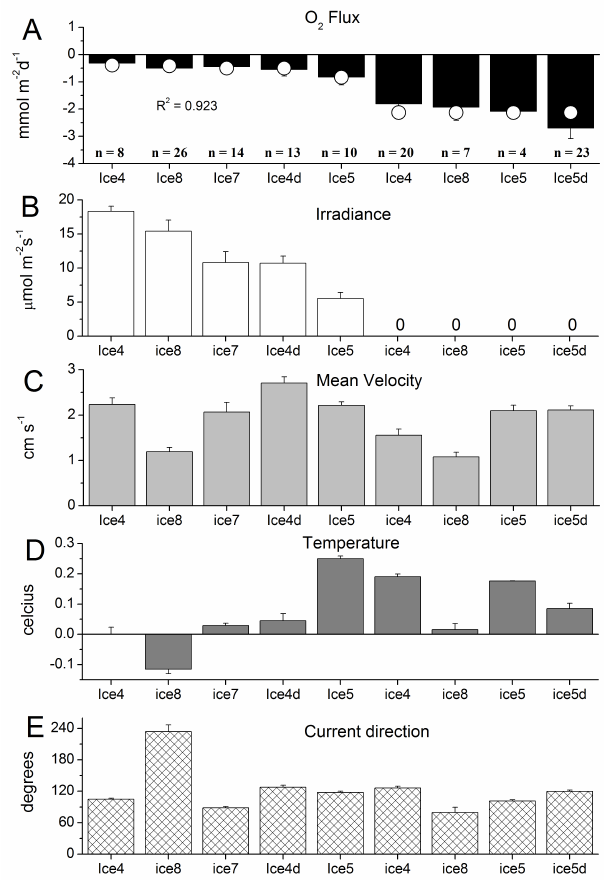
Fig. 5. Averaged O 2 fluxes for periods with well-developed turbu- lence under the ice-water interface are shown in (A) , where n repre- sents the number of 0.25h intervals included in each average. The open circles in (A) represent the flux determined by fitting Eqs. 3 and 4 simultaneously ( R 2 = 0.923) to the averaged fluxes. B, C, D , and E show the averages of under ice irradiance, mean current ve- locity, temperature and current angle over each period, respectively. All error bars represent standard errors.